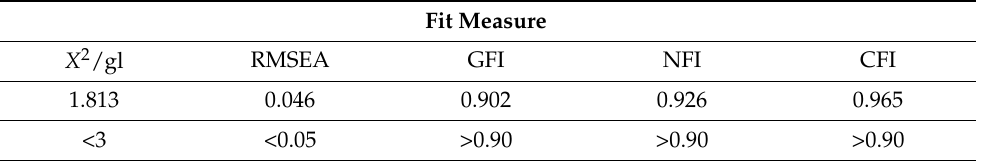
Table 2. Overall fit measures for the initial structural model.